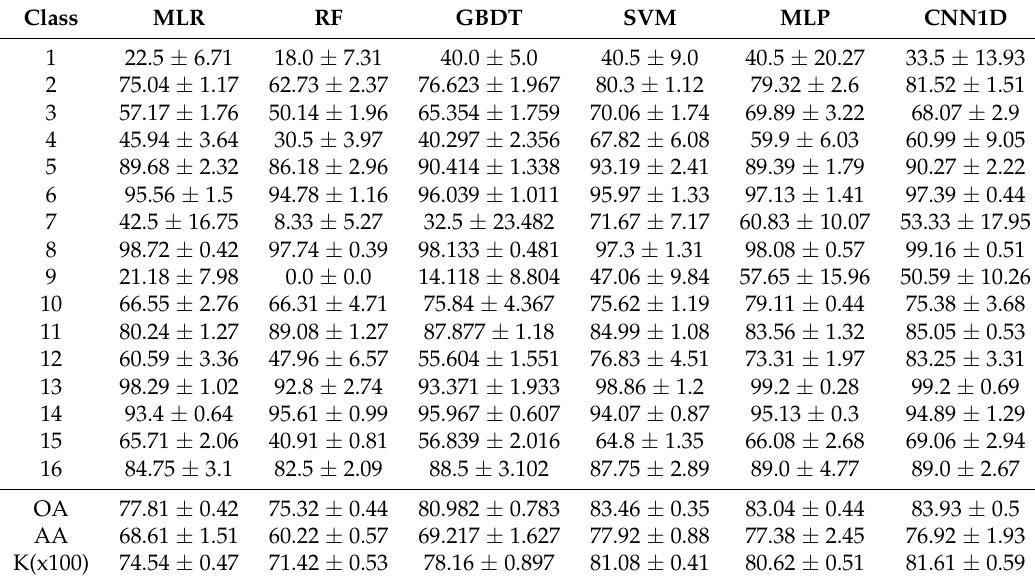
Figure 3. Accuracy comparison for different training set sizes on ( a ) IP, ( b ) UP, ( c ) KSC and ( d ) SV. Table 5. IP data set